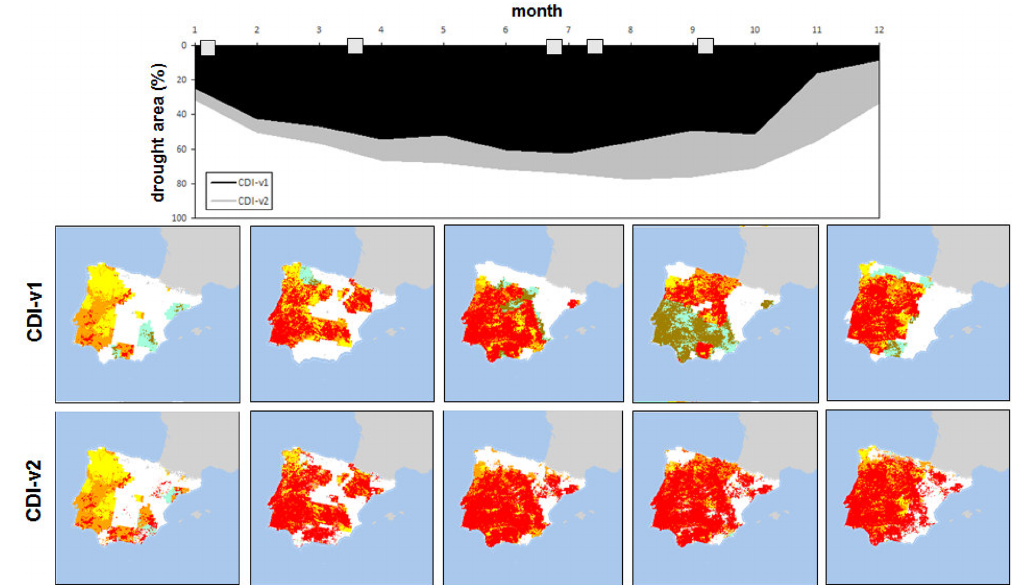
Figure 8. Temporal evolution of the 2005 Iberian Peninsula drought according to the two versions of the CDI. The upper plot shows the percentage of the area under drought (WATCH + WARNING + ALERT, in black for CDI-v1 and in grey for CDI-v2), whereas the lower images depict the spatial distribution of CDI-v1 (upper row) and CDI-v2 (lower row) for the selected dekads (demarked in the upper plot by the squares on the x axis).